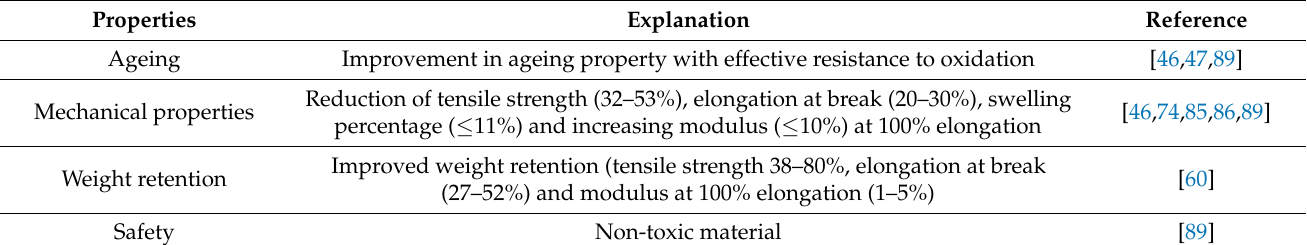
Table 20. Significant properties of MPP